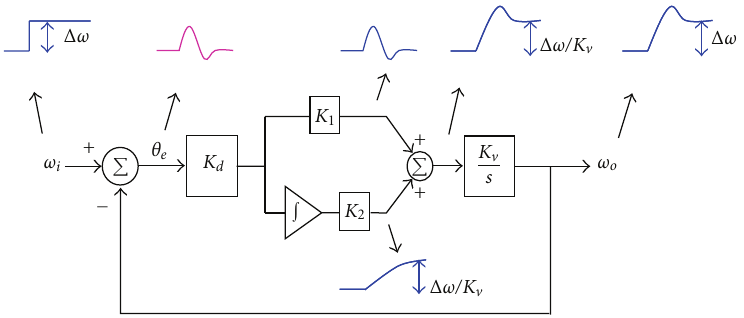
Figure 3: State-variable model of type II PLL.